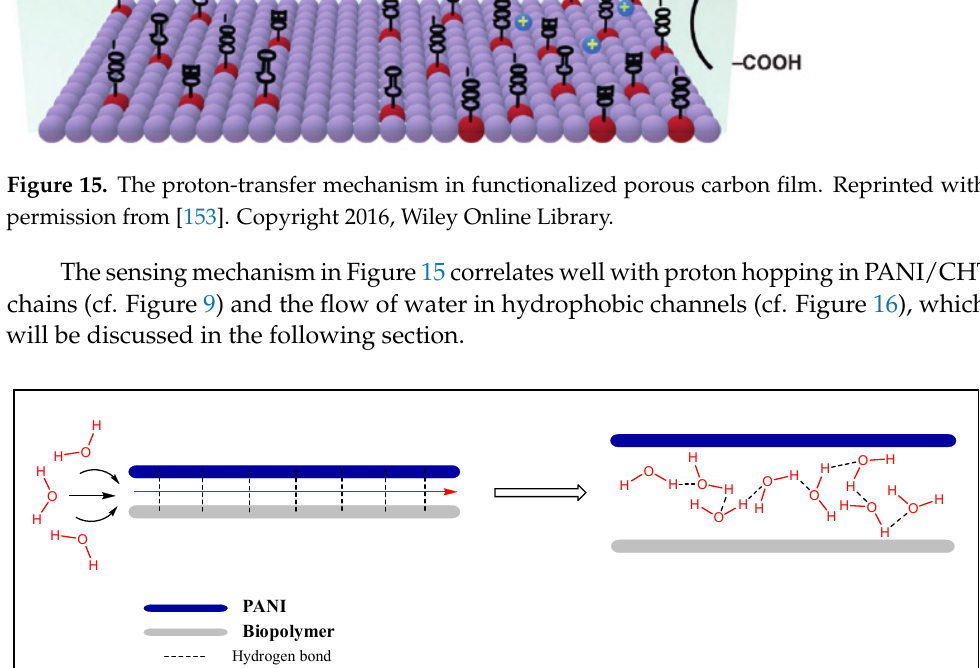
Figure 14. Hysteresis response curves for various composites: ( a ) PANI/CNF/PVA; ( b ) PANI/NFC/PVA; and ( c ) PANI/CHN. Panels ( a , b ) reprinted with permission from [12]. Copyright 2019, Elsevier. Panel ( c ) reprinted with permission from [10]. Copyright 2010, Elsevier.